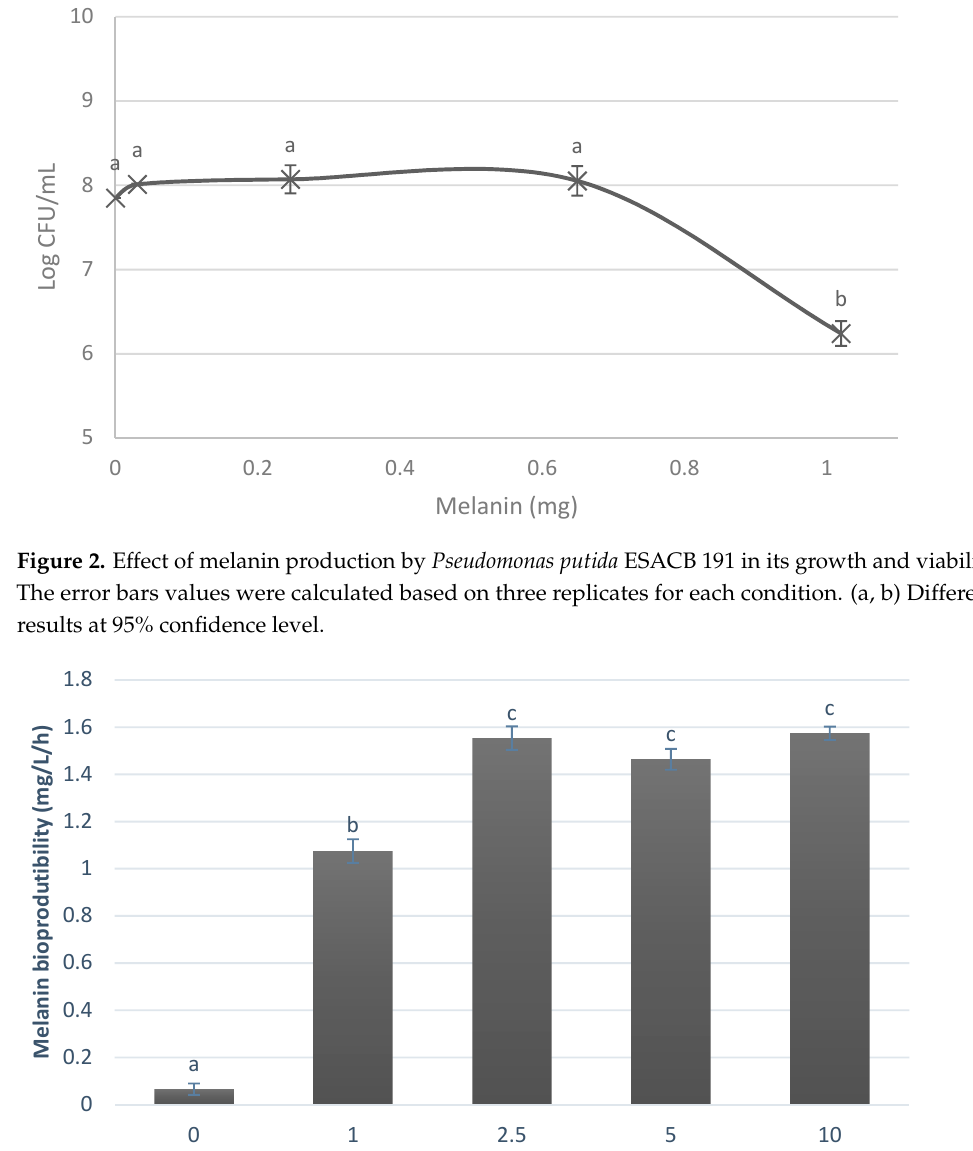
Figure 2. Effect of melanin production by Pseudomonas putida ESACB 191 in its growth and viability. The error bars values were calculated based on three replicates for each condition. (a, b) Different results at 95% confidence level.